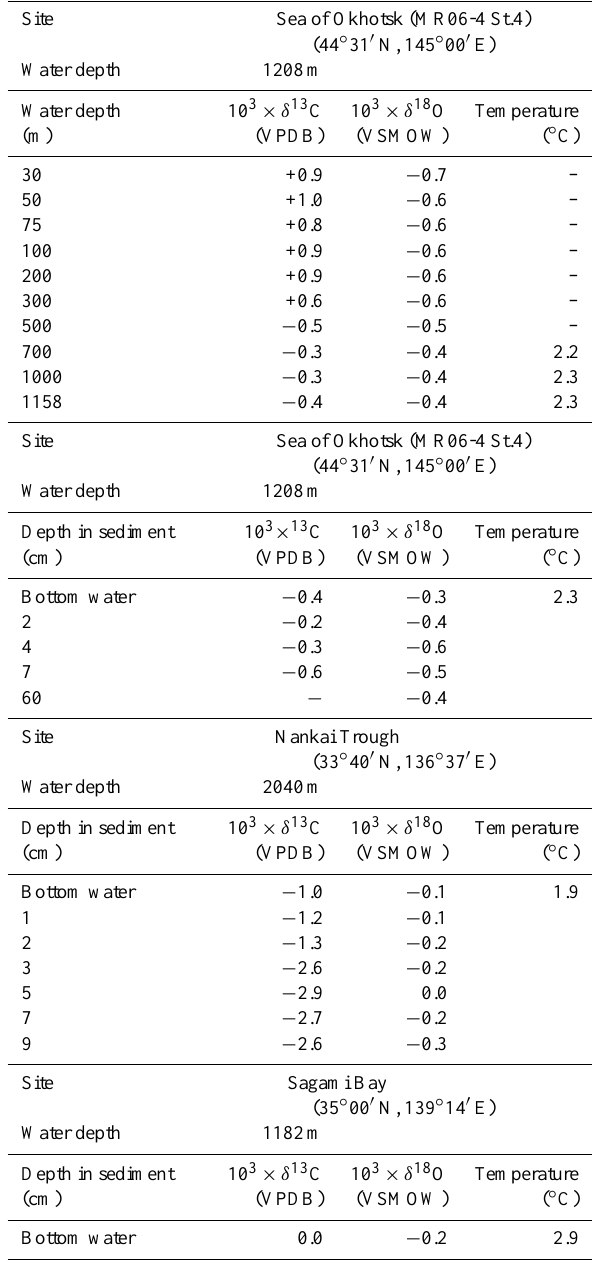
Table 1. δ 13 C of dissolved inorganic carbon, δ 18 O of water sam- ples, and water temperature in the study area. Sediment intervals are ± 0.5cm. Bottom water samples are collected with